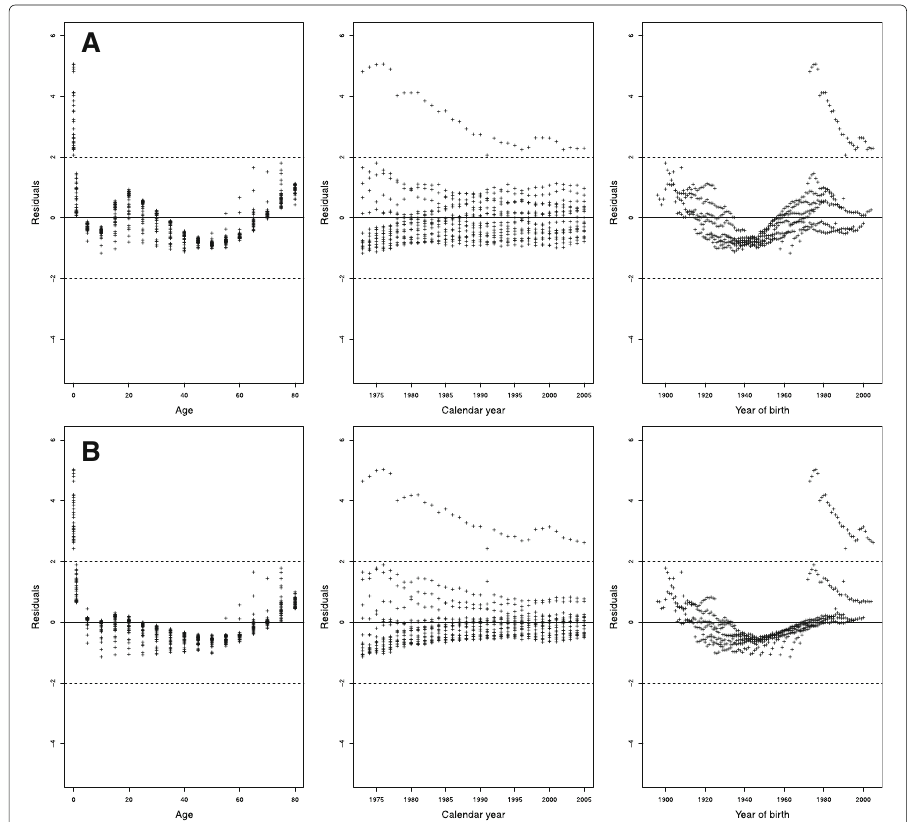
Fig. 1 Scatter plots of standardized deviance residuals for the CBD model for the training period 1973–1997. Dashed lines represent interval ( − 2, 2). a CBD for men. b CBD for